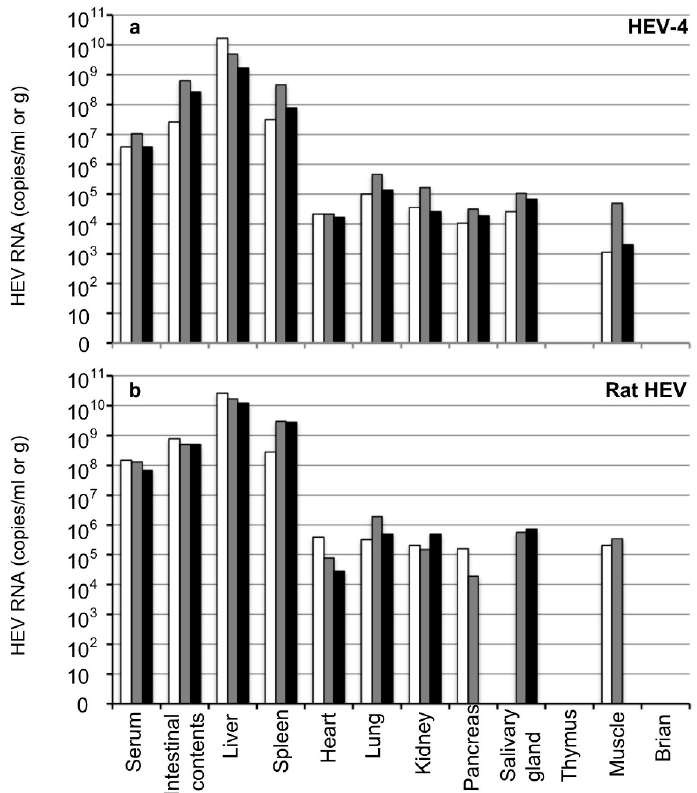
Figure 3. Detection of the viral RNA in the tissues in the early stage of infection. Six Mongolia gerbils were randomly separated into two groups ( n = 3 per group). Individual gerbils are indicated by white, gray and black bars. One group was inoculated with HEV-4 ( a ) and the other with rat HEV ( b ) via intraperitoneal injection. All gerbils were euthanized on day 14 p.i. The serum samples, intestinal contents, liver, spleen, heart, lung, kidney, pancreas, salivary gland, thymus, muscle and brain were collected, and the viral RNA was measured by